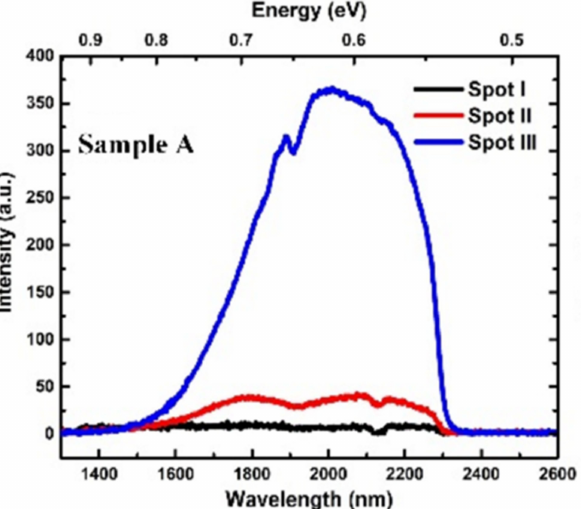
Figure 8. Room-temperature PL spectra for GeSn grown by PECVD technology (the Sn content is 6%). Reproduced from [114], open access by OSA Library,